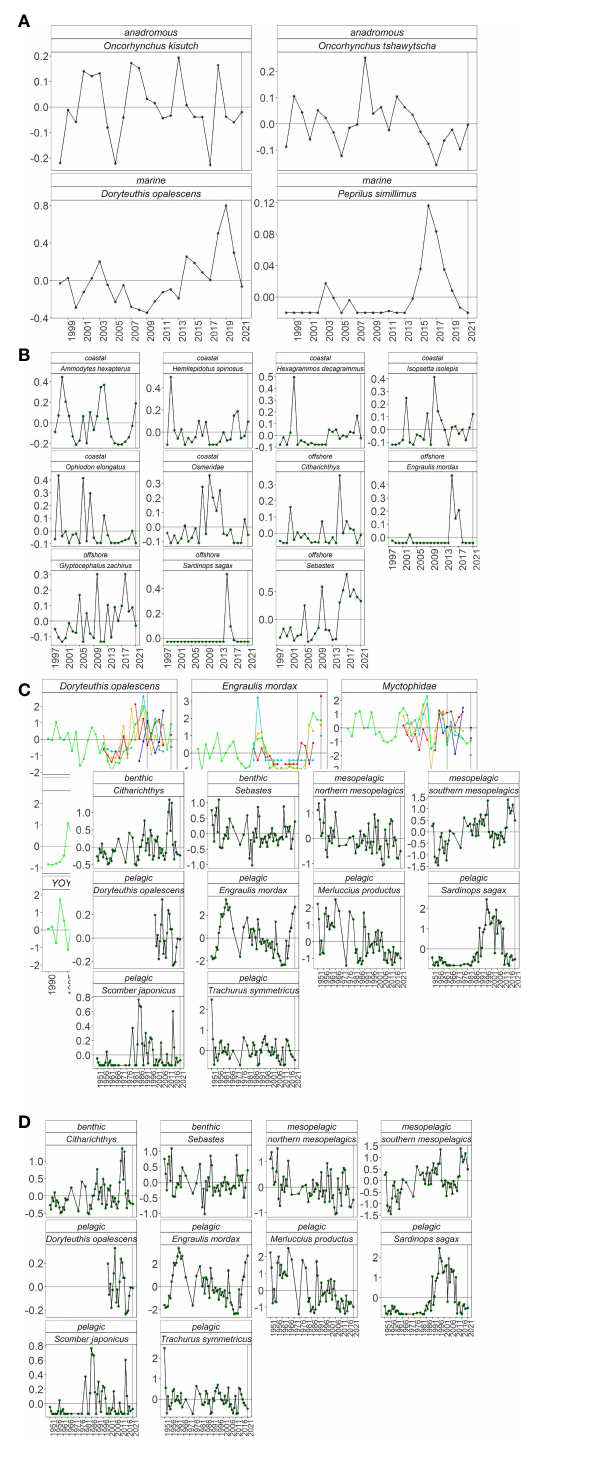
FIGURE 6 Anomalies of fi sh abundance from (A) JSOES, (B) NHL, (C) RREAS, and (D) CalCOFI. Panels within surveys depict different fi shes. For RREAS, colors depict the survey region as in Figure 1: dark blue is north, light blue is north central, green is core, orange is south central, and red is